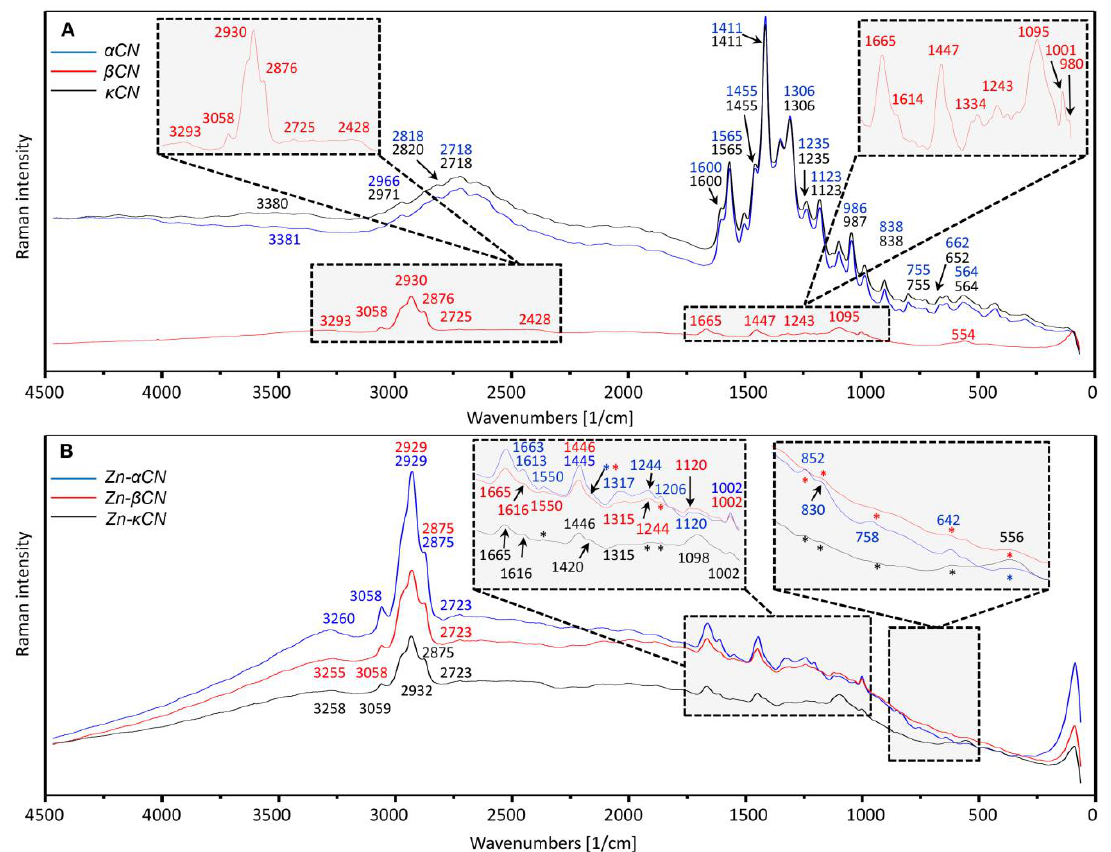
Figure 5. Raman spectra of the α S1 CN, β CN and κ CN casein isoforms control ( A ) and casein isoforms after binding of zinc ions ( B ). Asterisks (*) indicate band disappearance.